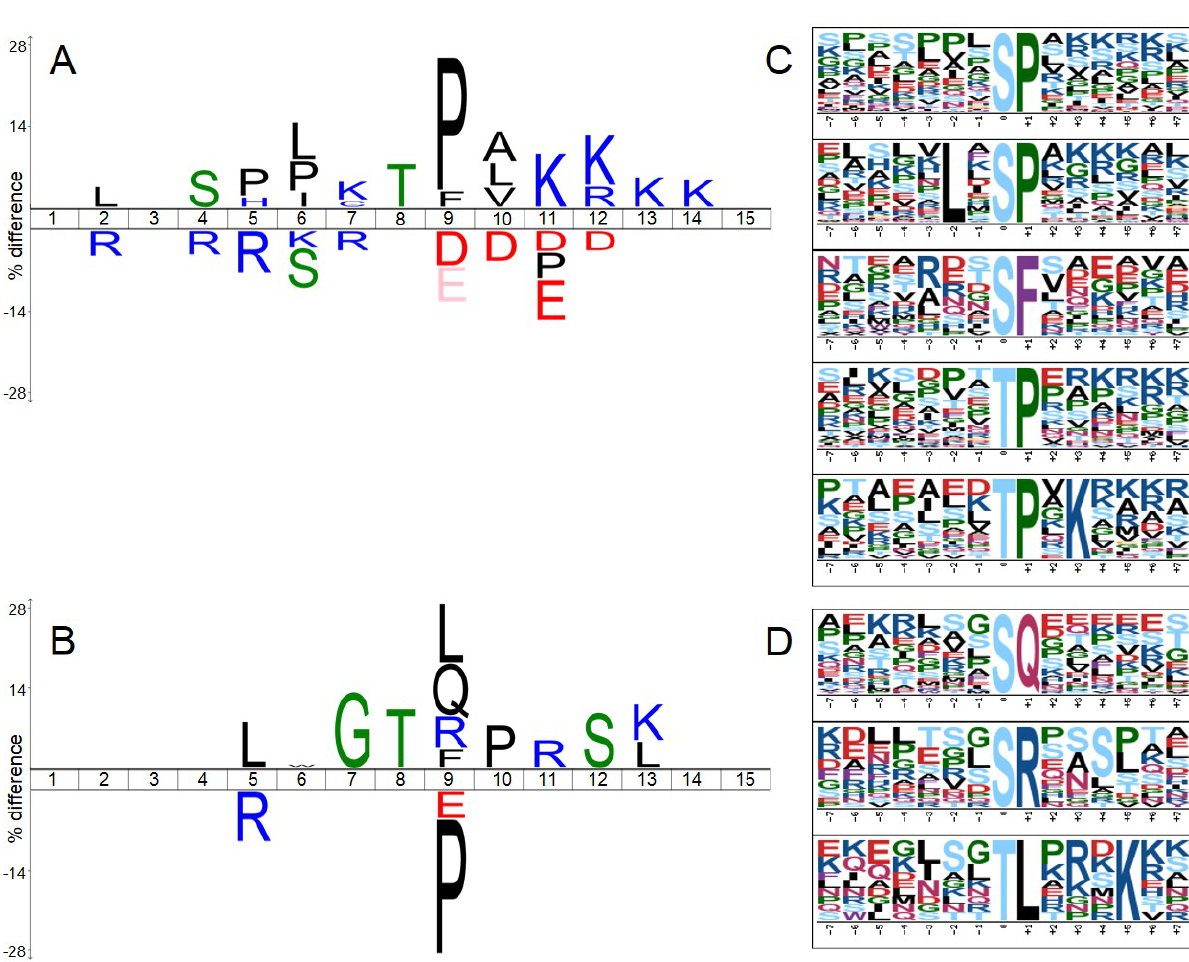
Figure 4. Sequence motifs analyses and visualization performed using iceLogo tool ( A , B ) and motif-x algorithm ( C , D ). The amino acid sequences of significantly differentially up- or down-regulated phosphorylation sites ( A , C or B , D respectively) were analyzed against a statistical background comprising all class I sites revealed in our study. In A and B , amino acids that were more frequently observed in the proximity of a regulated phosphorylation site are indicated over the middle line, whereas the amino acids with lower frequency are indicated below the line; phosphorylated amino acid is located at position 8; C and D depict sequence motifs extracted by motif-x algorithm at a significance level of p < 0.00003 (which approximately corresponds to a q -value of 0.01 after Bonferroni correction for multiple hypothesis